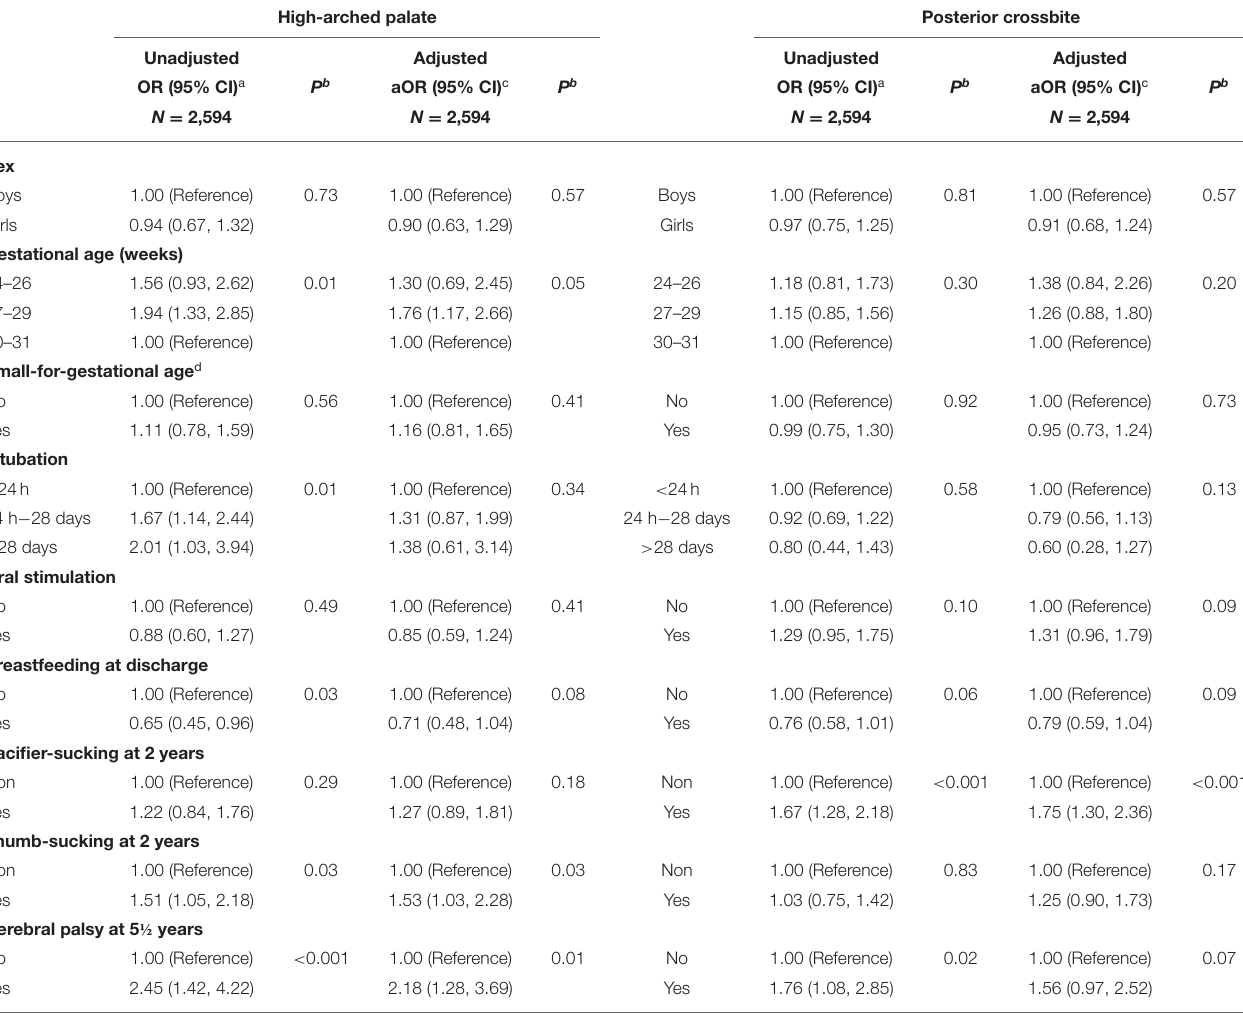
TABLE 4 | High-arched palate and posterior crossbite at 5 ½ years by neonatal characteristics, non-nutritive sucking habits (NNSHs) at 2 years and cerebral palsy at 5 ½ years: unadjusted and adjusted odds ratios (ORs), multivariable regression models with generalized estimating equations (GEEs) and multiple imputation ( n = 2,594). High-arched palate Posterior crossbite Unadjusted Adjusted